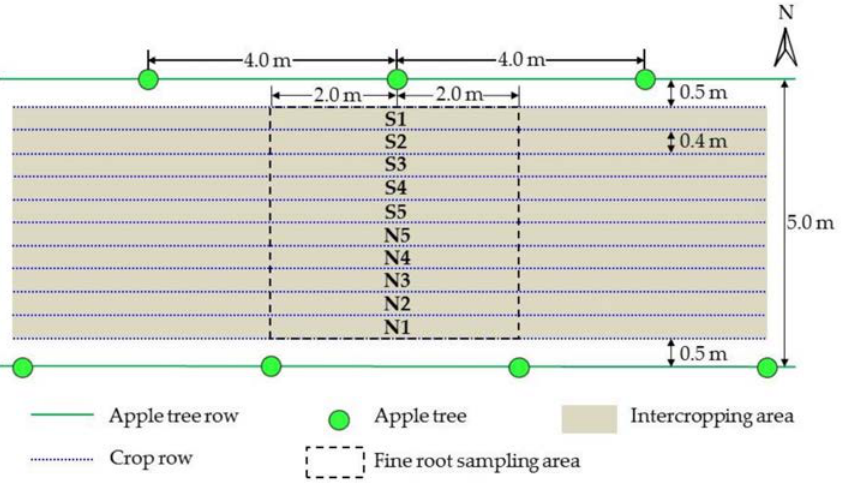
Figure 1. Location of sampling sections in apple–crop intercropping systems. The fine-root sampling area was divided into ten equally size sections, which were denoted as S1, S2, S3, S4, S5, N5, N4, N3, N2, and N1.